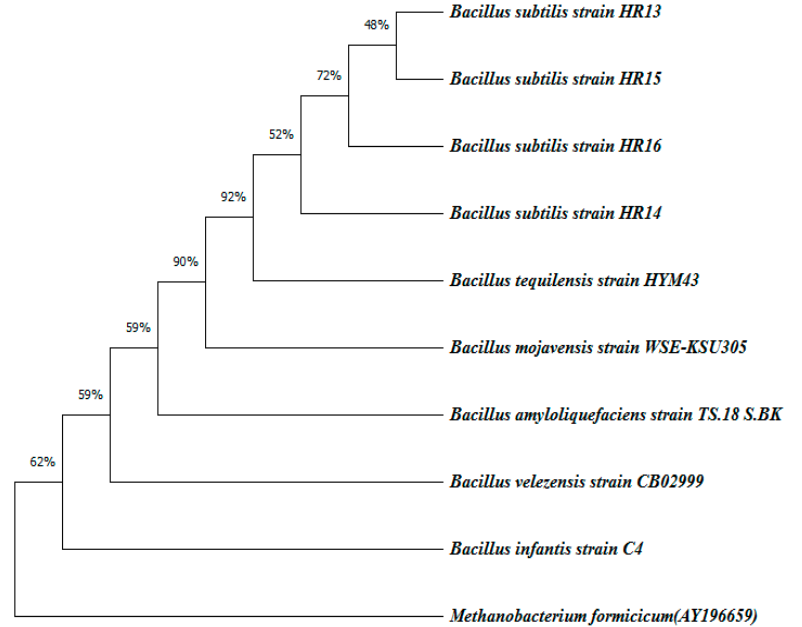
Figure 3. Phylogenetic tree of 16S rRNA nucleotide sequences in the analyzed strains (0.05 nucleo- tide replacement rate per site).